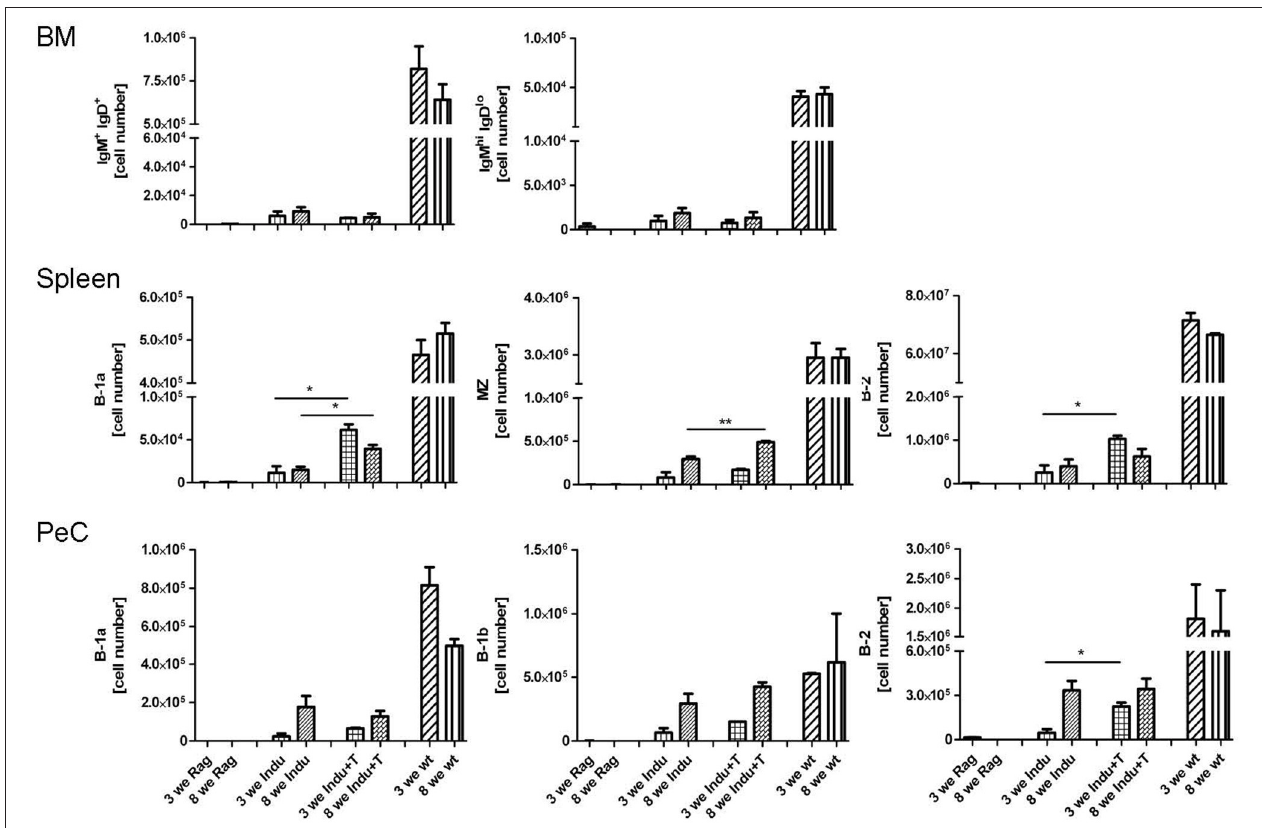
FIGURE 4 | Adoptive T cell transfer increases B cell numbers in spleen of TAM-treated B-Indu-Rag1 mice. As indicated, shown are absolute numbers of different BCR + B cell populations (IgM + IgD + , IgM high IgD low , B-1a, B-1b, B-2) at different anatomical sites (top: BM; middle: spleen; bottom: peritoneal cavity, PeC) and 3 and 8 weeks after initiation of the experiment. Note that, in addition to cohorts of B-Indu-Rag1 mice ± adoptive T cell transfer 1 day prior to TAM administration (Indu; Indu + T), we included Rag1 − / − and Wt mice for comparison ( n = 3–4 mice per group). Graphs depict mean values ± SEM; asterisks in graphs indicate the level of significance comparing “Indu” and “Indu + T”. The experiments were carried out at least